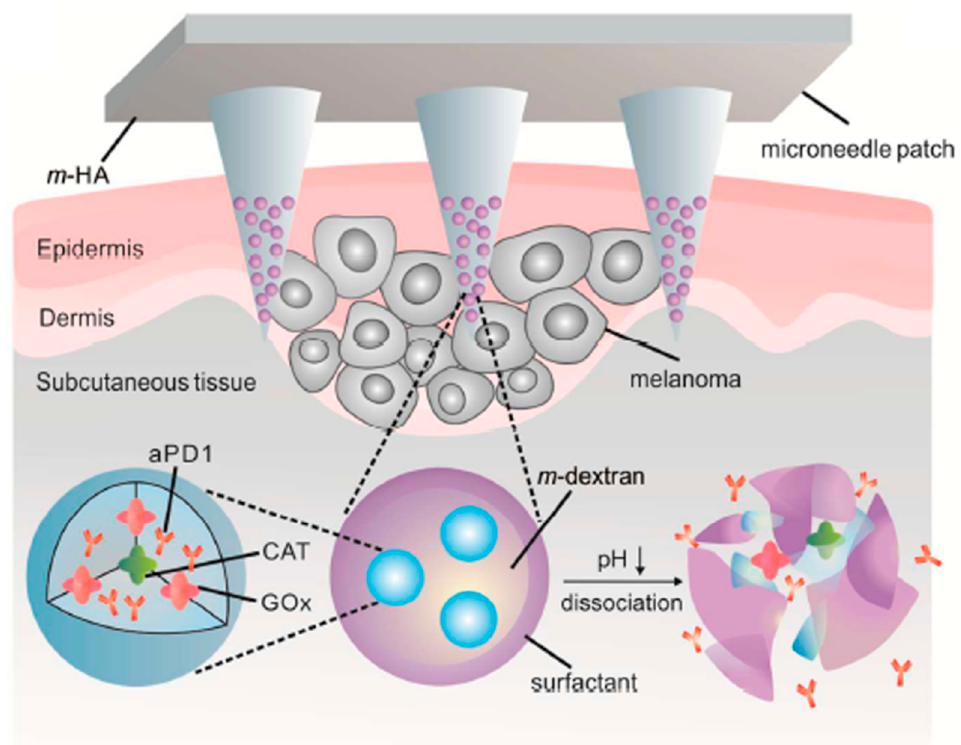
Figure 3. A schematic representation of anti-PD-1 (programmed death-1 pathway) (aPD1) delivery via microneedle patch loaded with nanoparticles. The glucose oxidase/catalase (GOx/CAT) enzymatic system was immobilized inside the nanoparticles, which resulted in the conversion of blood glucose to gluconic acid, resulting in the dissociation of nanoparticles, subsequently leading to the release of aPD1. Reproduced from Wang et al. [79], Open Access.